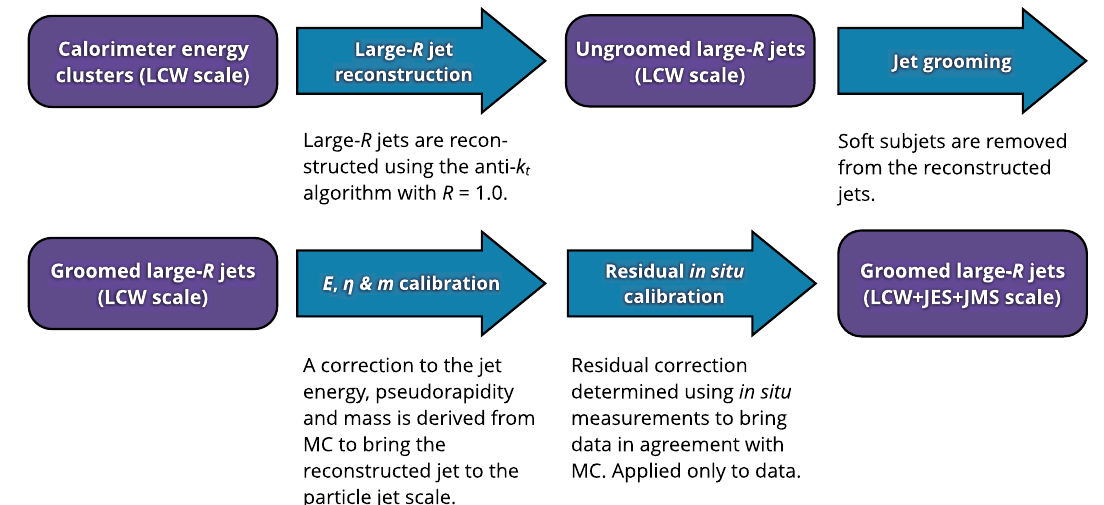
Fig. 2 Schematic representation of the events used to measure the JES and JER: a a dijet event, b a Z +jet or γ +jet event and c a multijet event with several jets recoiling against the leading (large- R ) jet. The labels